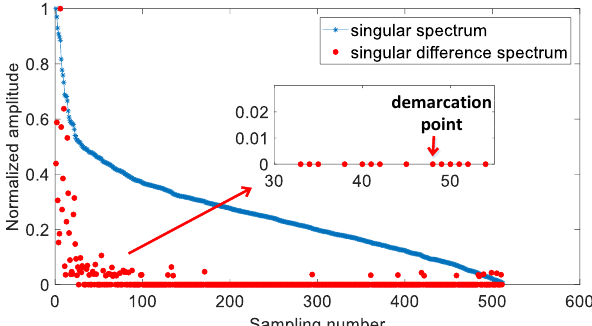
Figure 4. Singular spectrum and singular value difference spectrum of the received signal at the SNR of −6 dB.